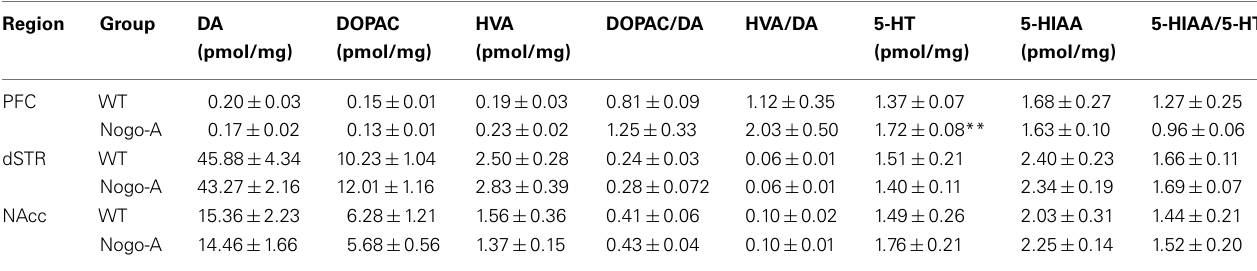
Table 1 | Brain tissue concentrations of monoamine neurotransmitters and their metabolites as well as monoamine turnover rates inWT and Nogo-A KD rats